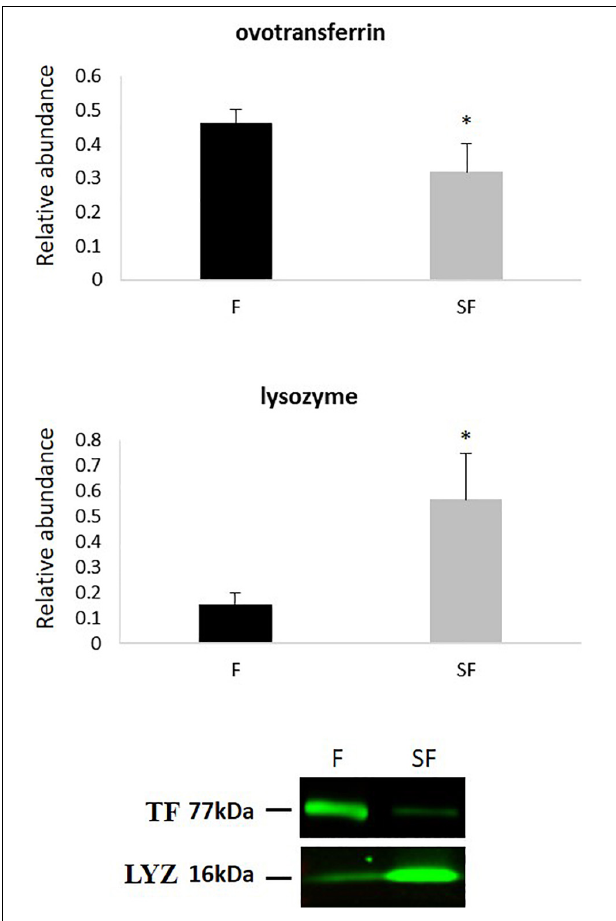
FIGURE 4 | Western-blot quantification and signals of ovotransferrin (TF) and lysozyme (LYZ) in sperm from fertile (F) and subfertile (SF) roosters. * p < 0.05.